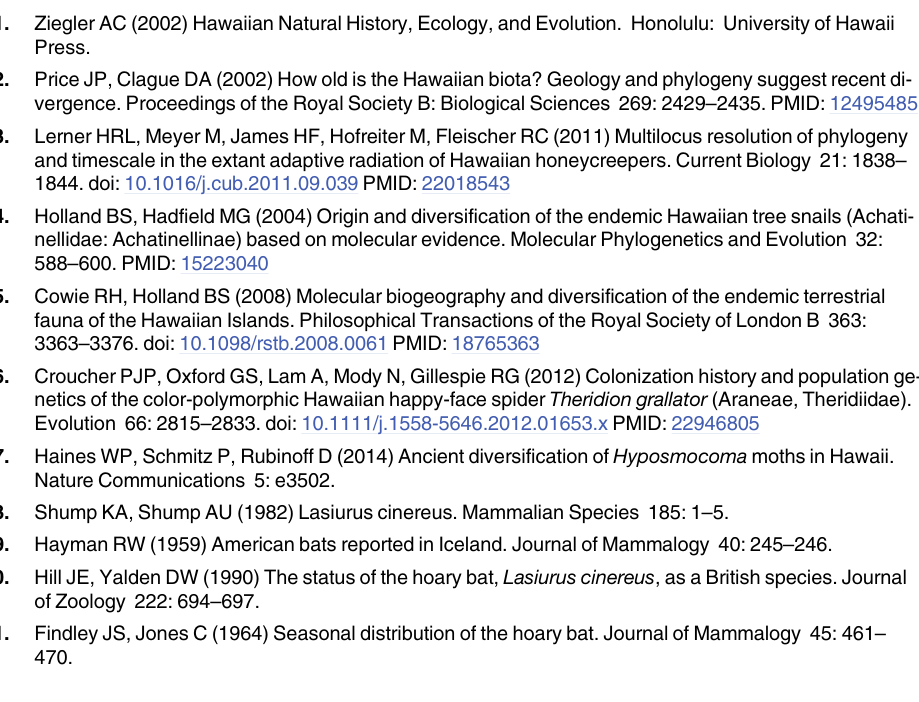
S3 Table. Locus-specific AMOVAs quantifying genetic structure between individuals as- signed to the Hawaii1 and Hawaii2